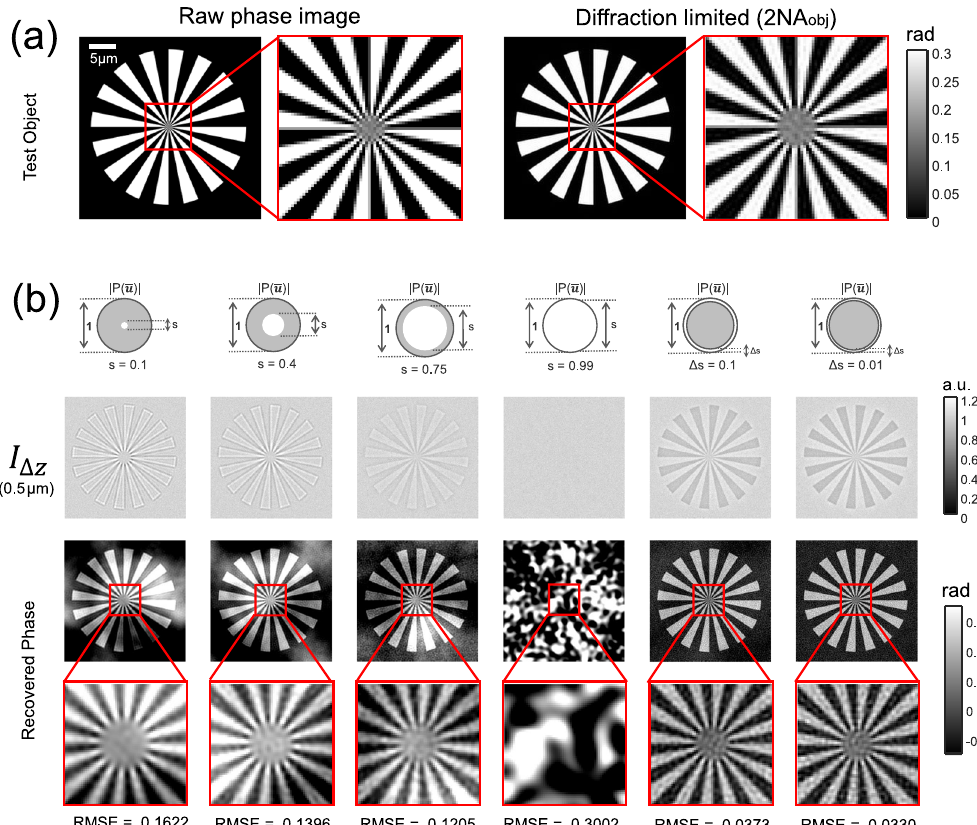
Figure 8. Comparison between annular illumination TIE and circular illumination TIE. ( a ) The raw Siemens star image and the corresponding best diffraction limited image can be achieved based on the simulation parameter. ( b ) Comparison of over-defocus images and reconstruction results of different illumination settings for a small defocus distance ( Δ z = 0.5 μ